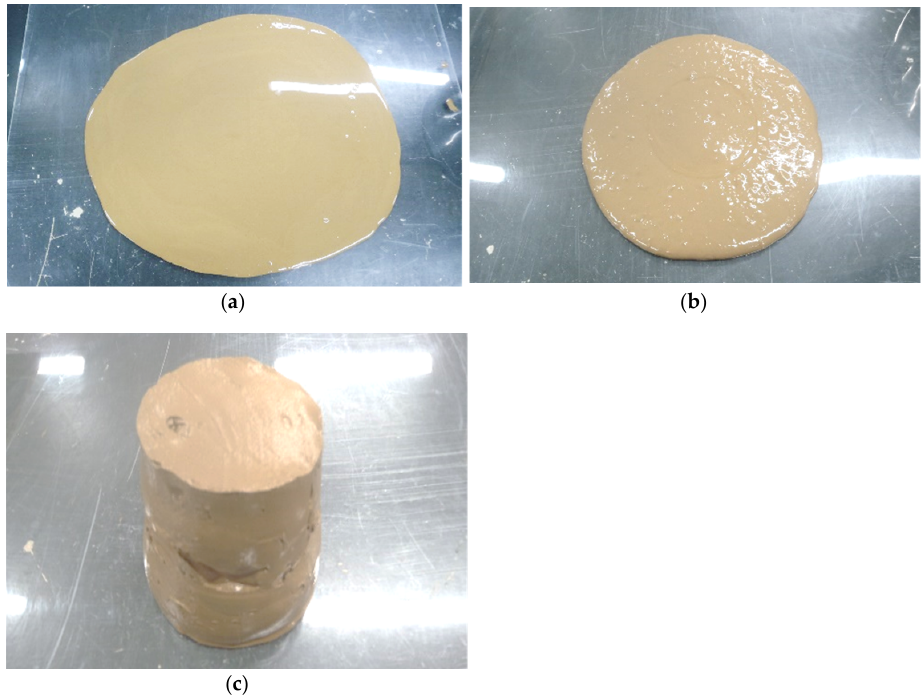
Figure 3. State of the flow test for specimens prepared from mixed samples of cohesive soil and slurry solution of each solidifying material. ( a ) B-type (equivalent to No. 11 in Table 3). ( b ) B-20-type (equivalent to No. 13 in Table 3). ( c ) C-type (equivalent to No. 14 in Table 3).